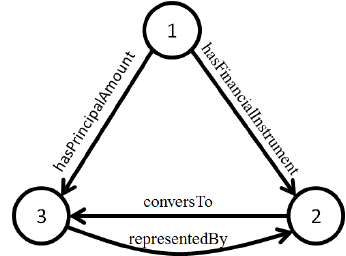
Figure 3. DGs for Common Equity Tier 1 Capital Ratio Calculation Process shown on Fig.